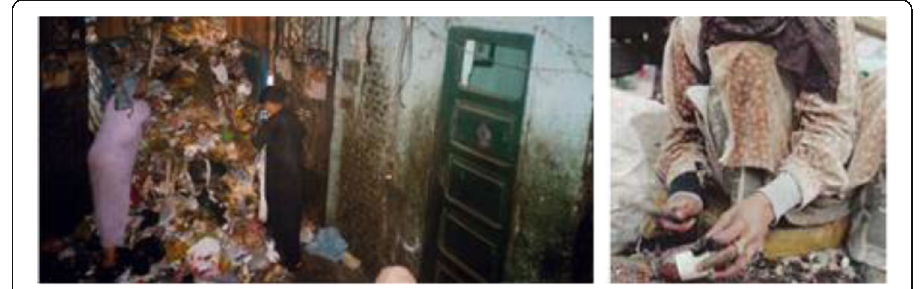
Fig. 3 Women and young girls sorting garbage in Manshiyat Nasser